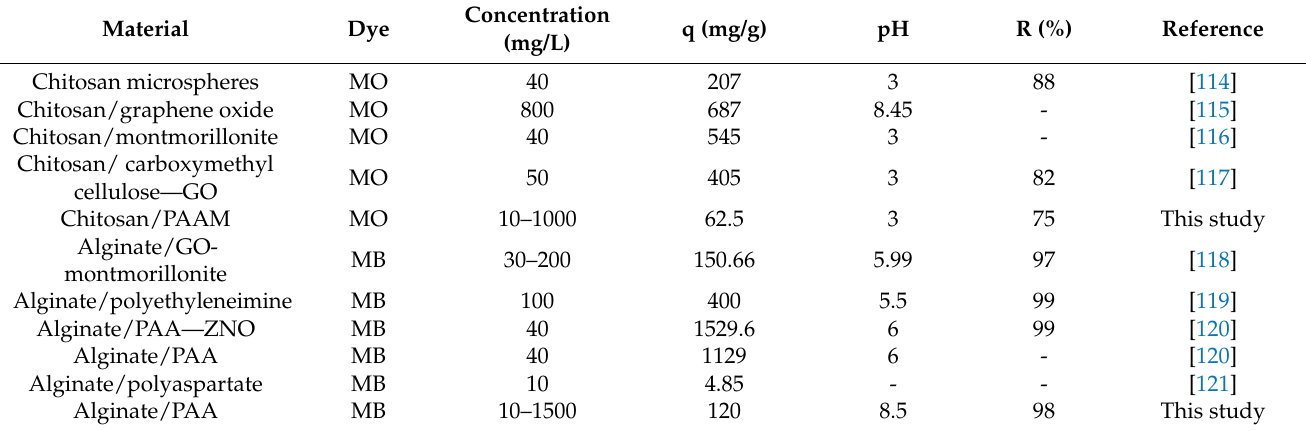
Table 3. Chitosan and alginate hydrogels adsorption